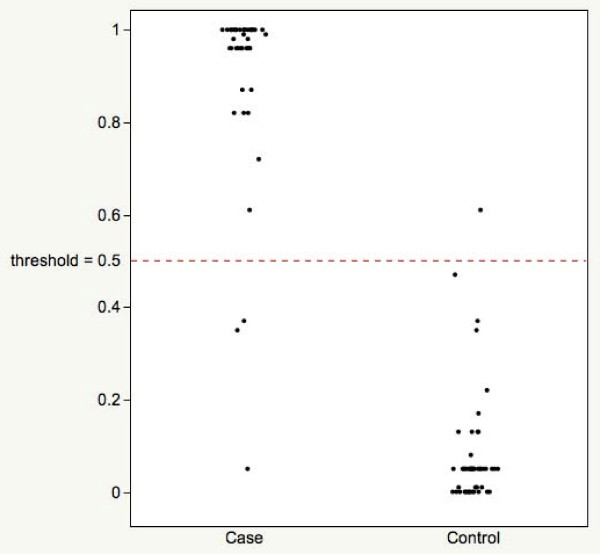
Predicted posterior probability values (ρP). Values were generated by multivariate modelling for each patient set of biomarkers for Case and Control cohorts.